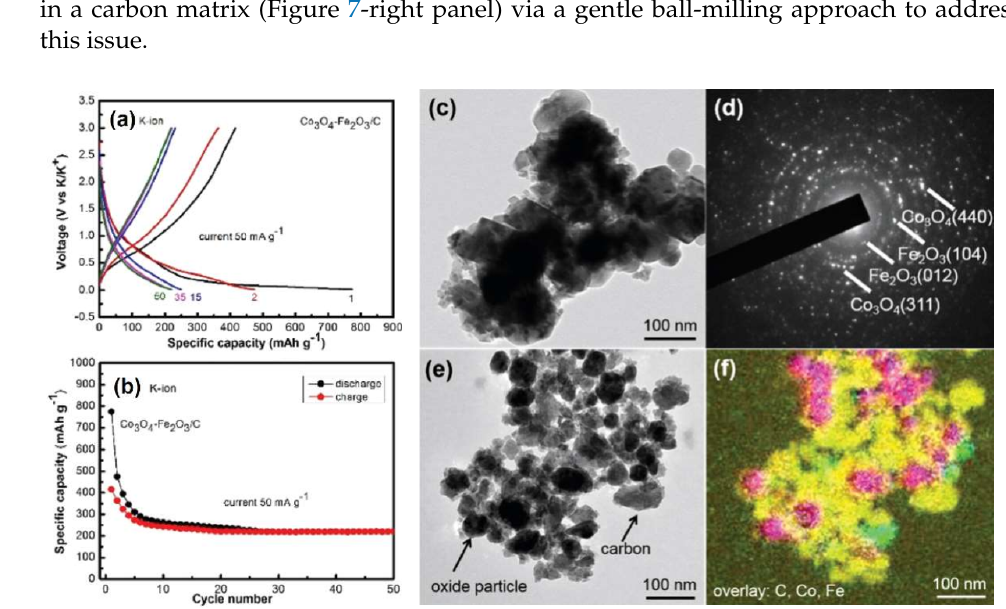
Figure 7. ( a ) Galvanostatic voltage profiles of charge/discharge for a number of selected cycles for a hybrid Co 3 O 4 –Fe 2 O 3 /C material cycled in a K half-cell at 50 mA g − 1 between 0.01 and 3.00 V vs. K + /K. ( b ) Cycle performance and capacity retention of the Co 3 O 4 –Fe 2 O 3 /C for the same K half-cell. ( c ) Bright-field transmission electron microscopy (TEM) of the Co 3 O 4 –Fe 2 O 3 material and ( d ) the corresponding selected area electron diffraction (SAED) pattern for this compound showing its nano-crystalline nature. ( e ) Bright-field TEM image of the hybrid Co 3 O 4 –Fe 2 O 3 /C together with ( f ) an overlay of chemical maps for the region displayed in ( e ) showing elemental Co, Fe and C maps. (Colour scheme: Cobalt, green; iron, red; carbon, yellow). Note the prominent capacity loss in the first cycle in ( a ) and ( b ), as well as the discrepancies between the discharge and charge capacities in ( b ) during the first 25 cycles. Reprinted with permission from Ref. [16]. Copyright 2022 Royal Society of